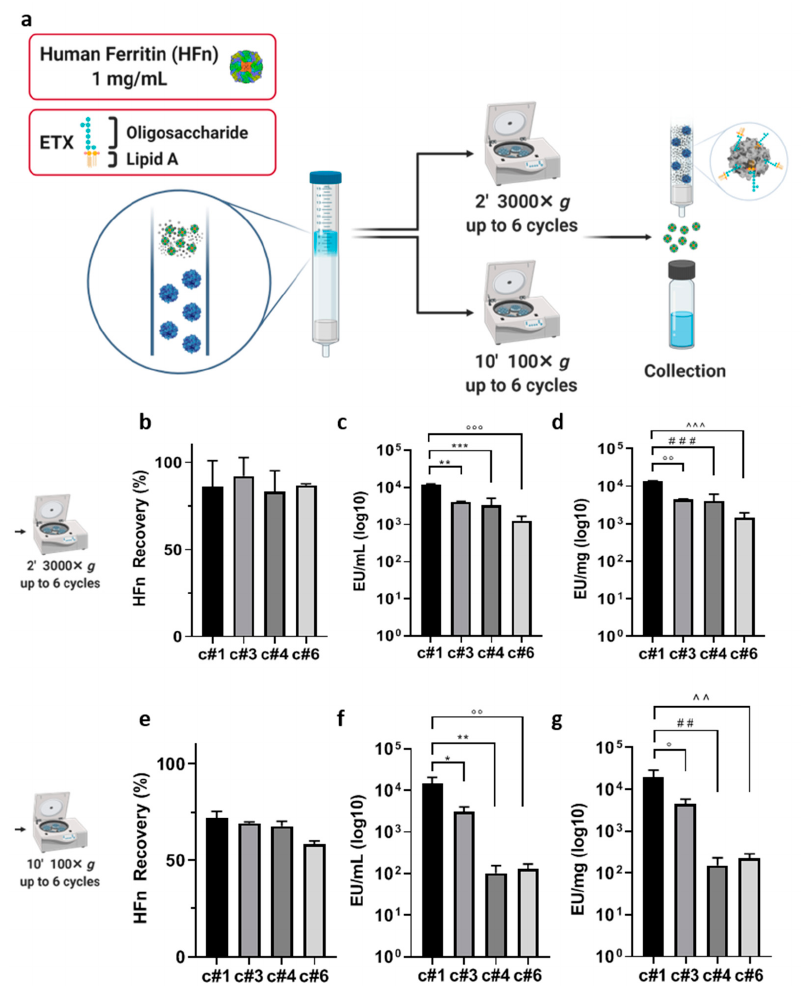
Figure 1. Purification strategy using Endotrap HD columns. The column was loaded with HFn (1 mg/mL) and centrifuged for up to six cycles at the speed of 3000× g for 2 ′ ( a ) or 100× g ( e ) for 10 ′ . The eluted protein suspension was reloaded in the upper part of the column after every cycle. H-ferritin nanocage (HFn) recovery was calculated by absorbance reading ( b, e ) and endotoxin (ETX) levels have been obtained by LAL test ( c, d, f, g ). Results from cycles 1, 3, 4 and 6 have been inserted in graphs and labelled as c#1, c#3, c#4 and c#6, respectively. Results are reported as average ± S. D. of 6 independent experiments. Statistical significance panels c and d: ** p = 0.0013, *** p = 0.0005, °°° p = 0.0001, °° p = 0.0013, ### p = 0.006, ^^^ p = 0.0002. Statistical significance panels f and g: * p = 0.0122, ** p = 0.0029, °° p = 0.0030, ° p = 0.0130, ## p = 0.0029, ^^. p = 0.0030.